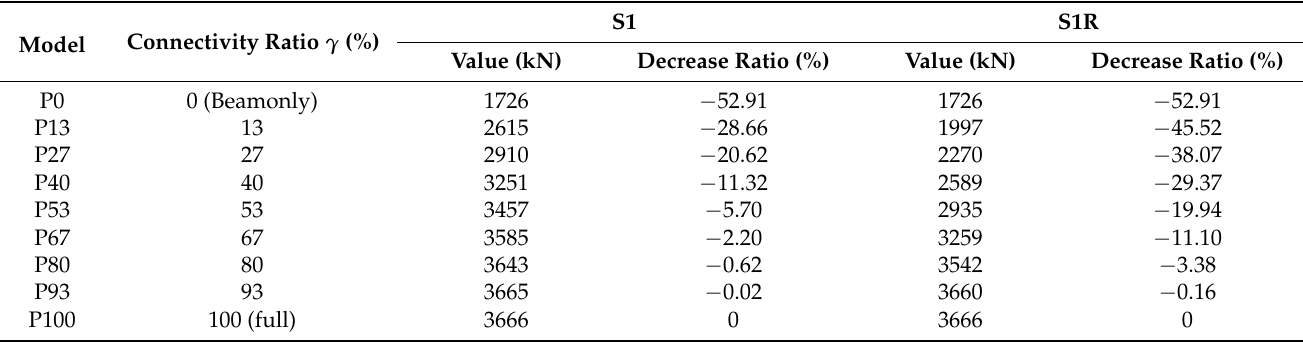
Table 3. Results of shear strength for S1 and S1R models.